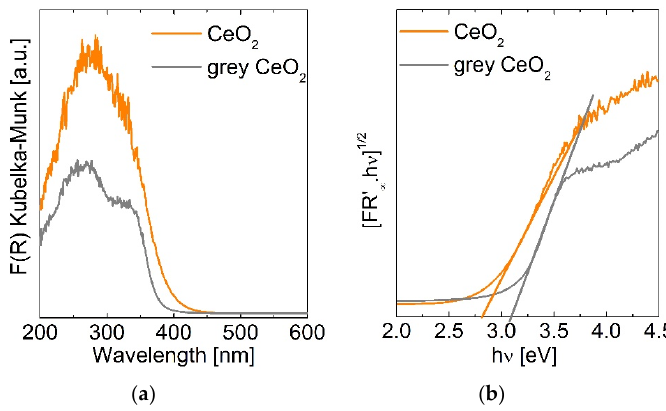
Figure 4. ( a ) UV-vis Diffuse Reflectance spectra of CeO 2 powders; ( b ) estimation of the optical band-gap of the samples by means of the modified Kubelka–Munk function.